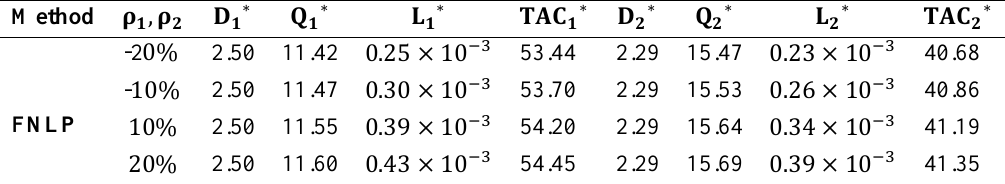
Table 8. Optimal solutions of MOIM for different values of 𝛒 𝟏 , 𝛒 𝟐 .